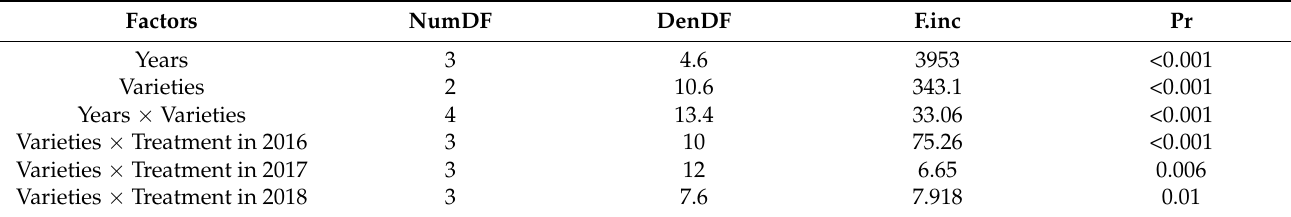
Table 2. ANOVA describing the interaction effect of variety and year on mean seed yield on Lentil in Marchouch Station. Factors Varieties